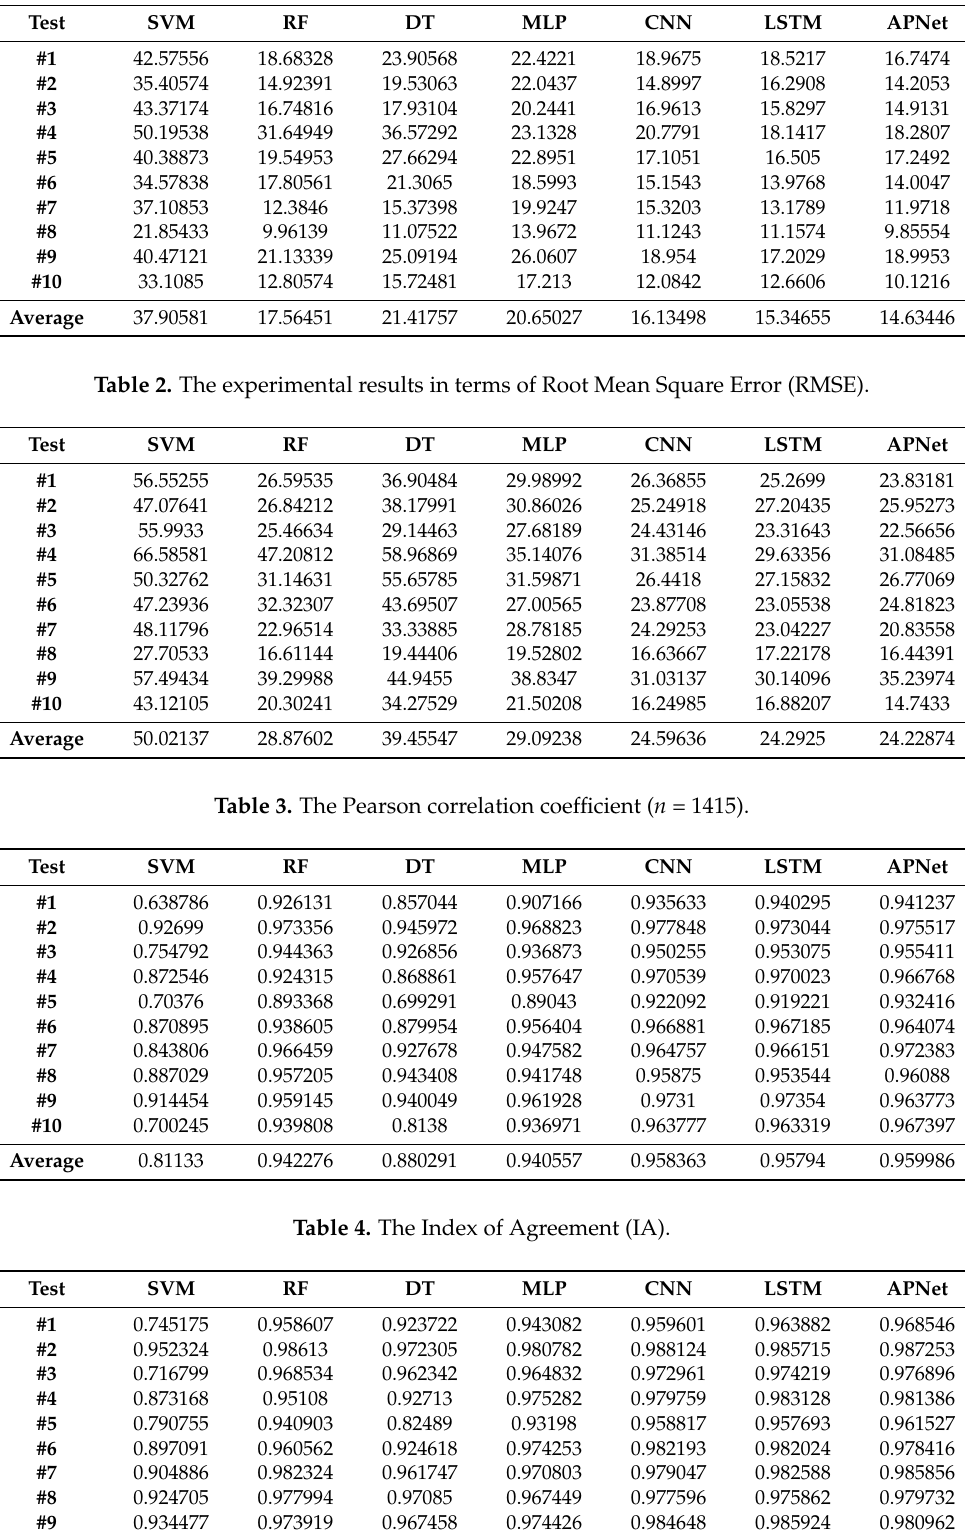
Table 1. The experimental results in terms of Mean Absolute Error (MAE).